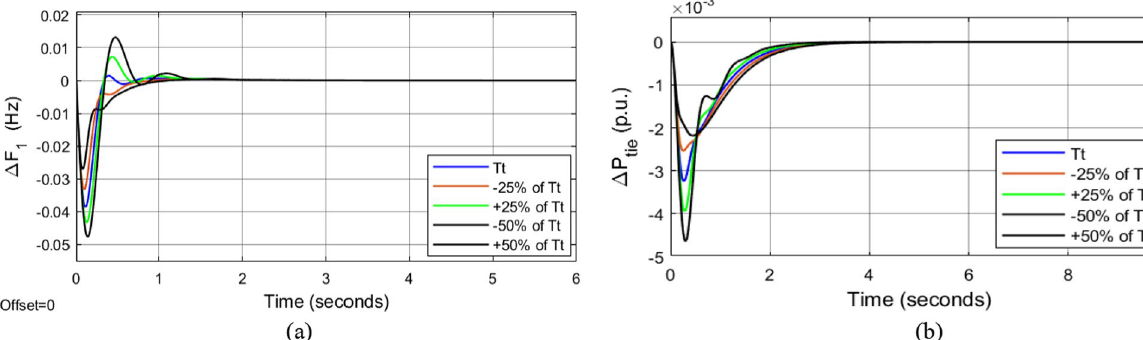
Fig. 9 Sensitivity analysis under variation of T t : a ΔF 1 and b Δ P tie